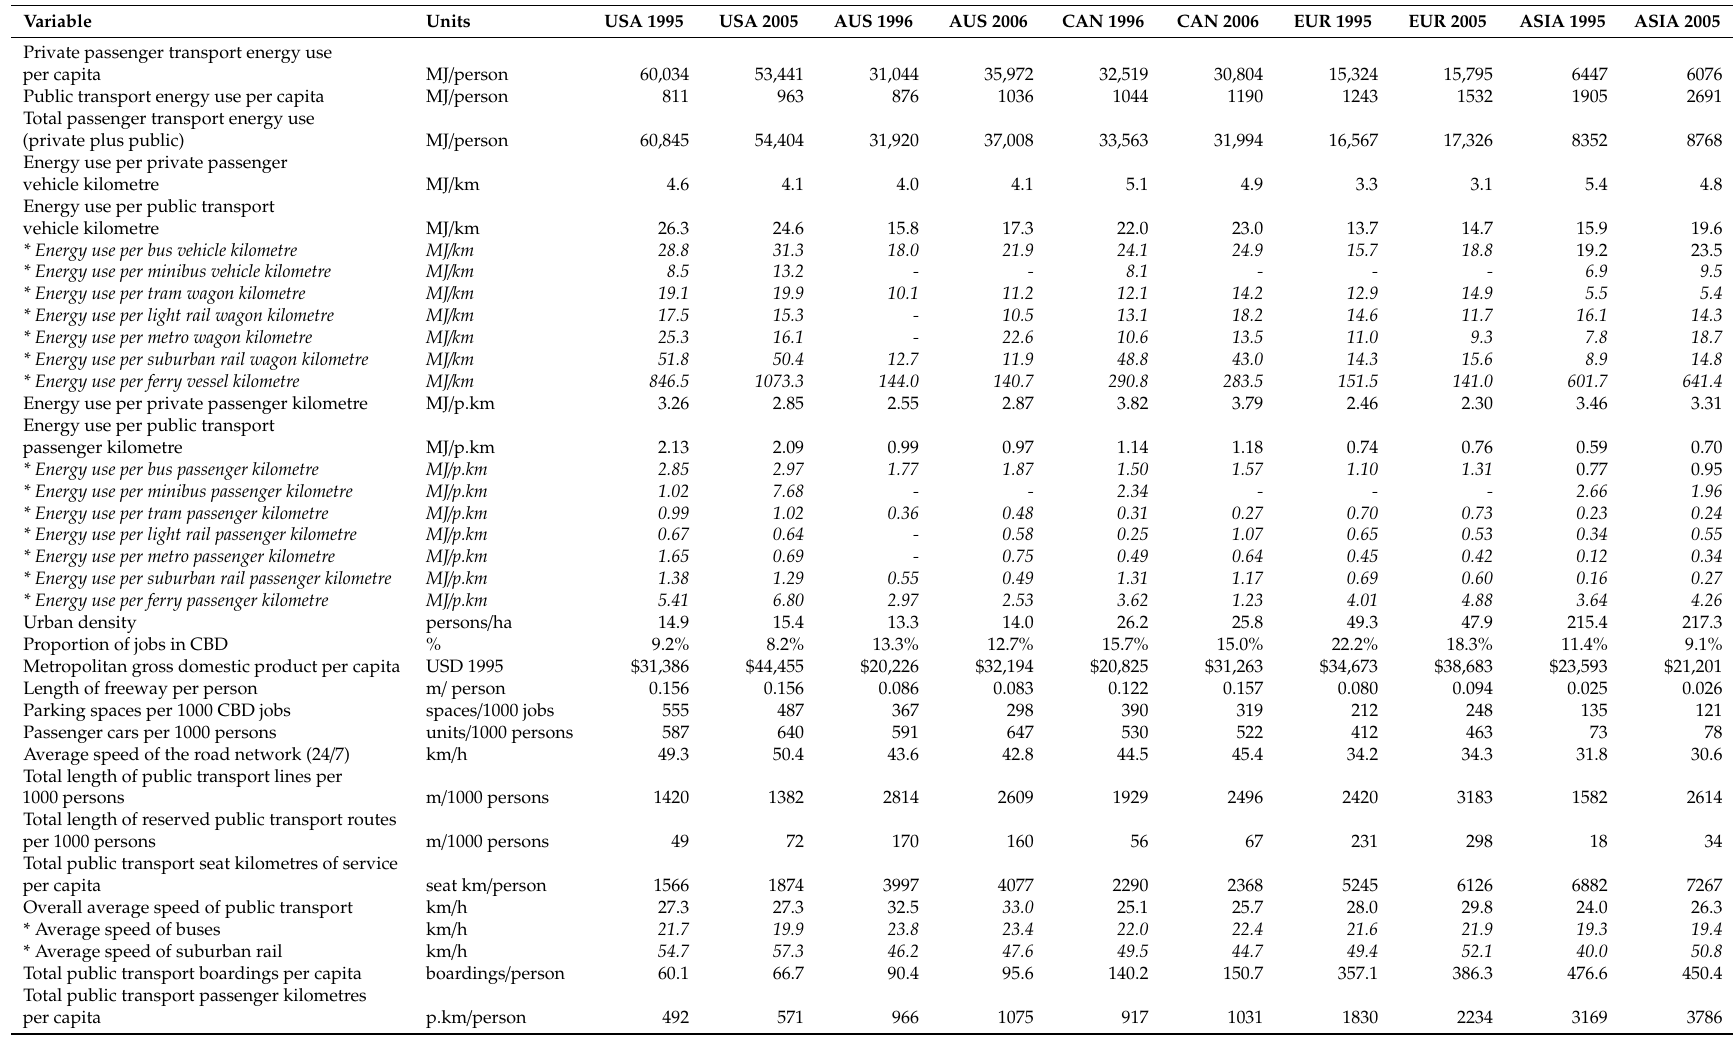
Table 2. Changes in energy, land use and transport-related variables in US, Australian, Canadian, European and Asian cities from 1995–1996 to 2005–2006.